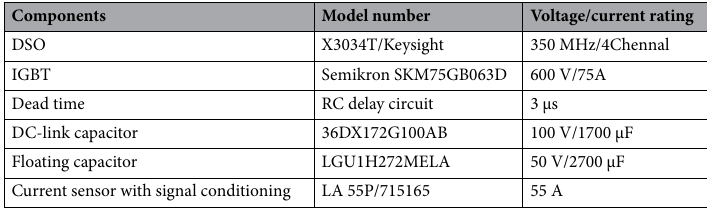
Table 7. Experimental components details and